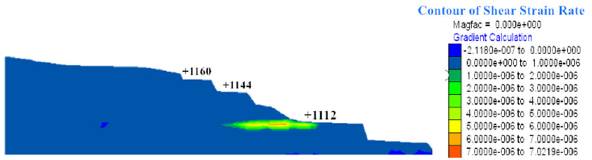
Fig. 14 Cloud chart of shear strain rate of P-1 section slope Fig. 15 Schematic diagram of plastic zone of slope in section